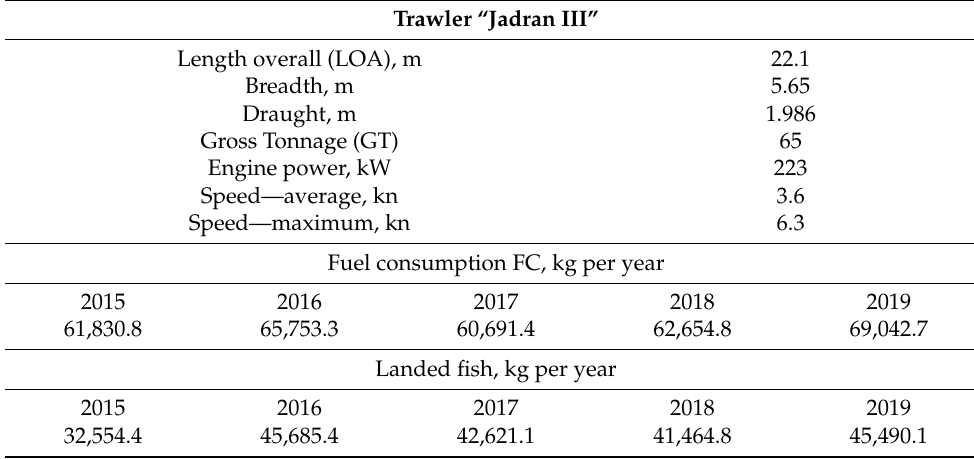
Table 3. Main particulars of the studied trawler.